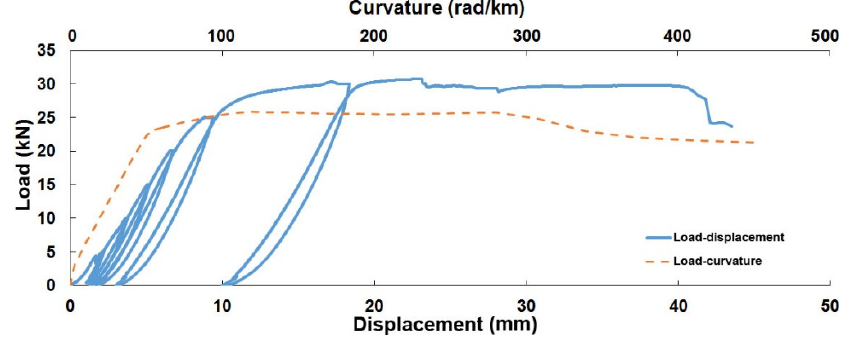
Figure 3 . Load ‐ curvature (dashed line) and load ‐ displacement diagrams (solid line).